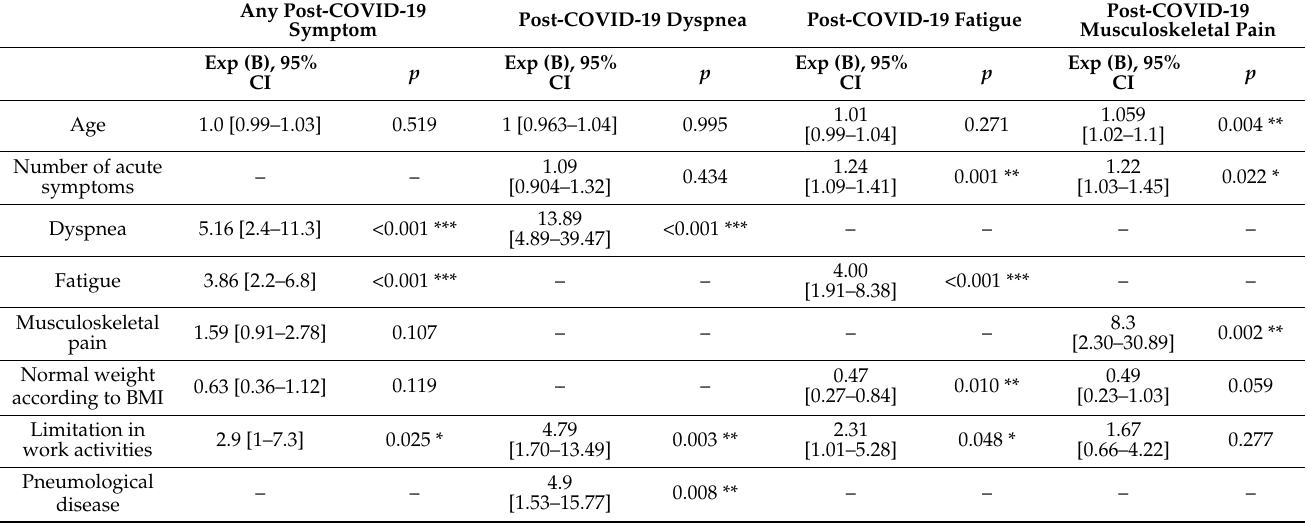
Table 3. Summary of results for the final multiple logistic regression